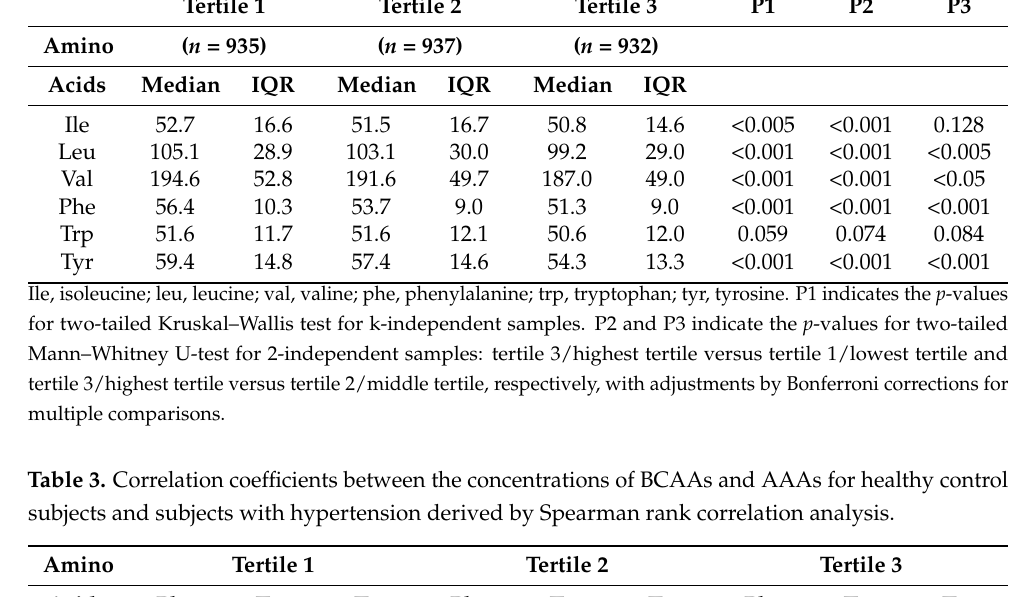
Table 2. BCAA and AAA concentrations ( µ mol/L) in the study populations. Values are shown as median and interquartile range (IQR). Tertile 1 Tertile 2 Tertile 3 P1 P2 P3 Amino ( n = 935) ( n = 937) ( n = 932) Acids Median IQR